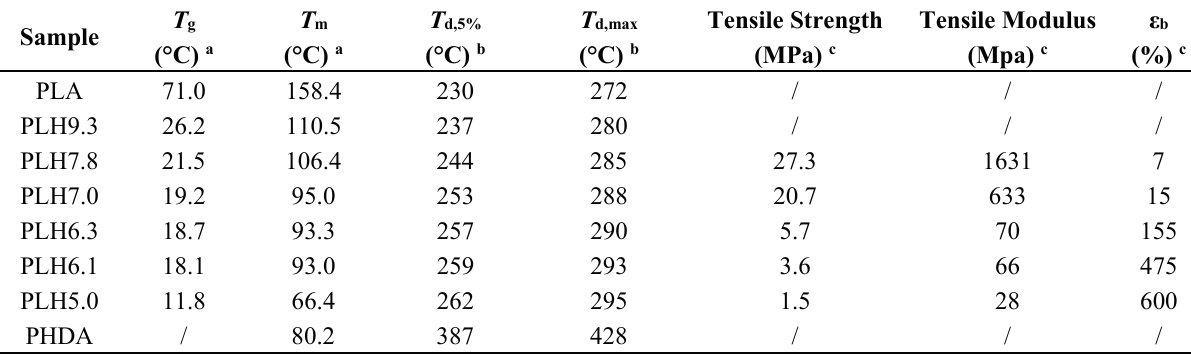
Table 2. Thermal properties of the PLH copolymers.